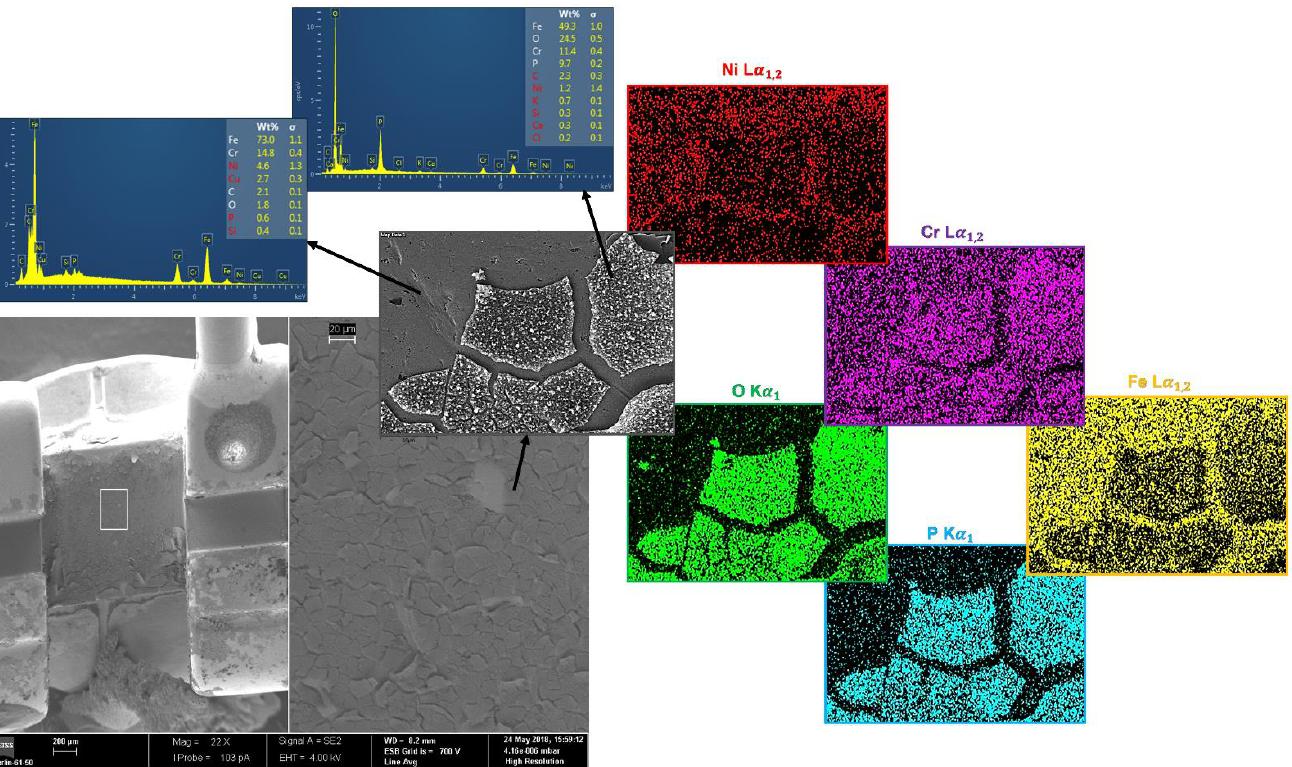
Figure 3. SEM surface micrographs and EDS analysis of brackets after the corrosion test at pH = 2.3.